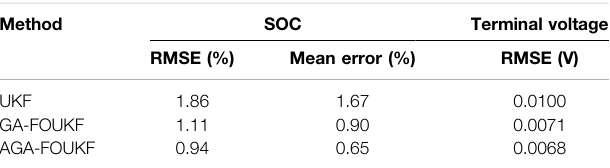
TABLE 5 | Statistics of estimated SOC and terminal voltage under dynamic experiment.